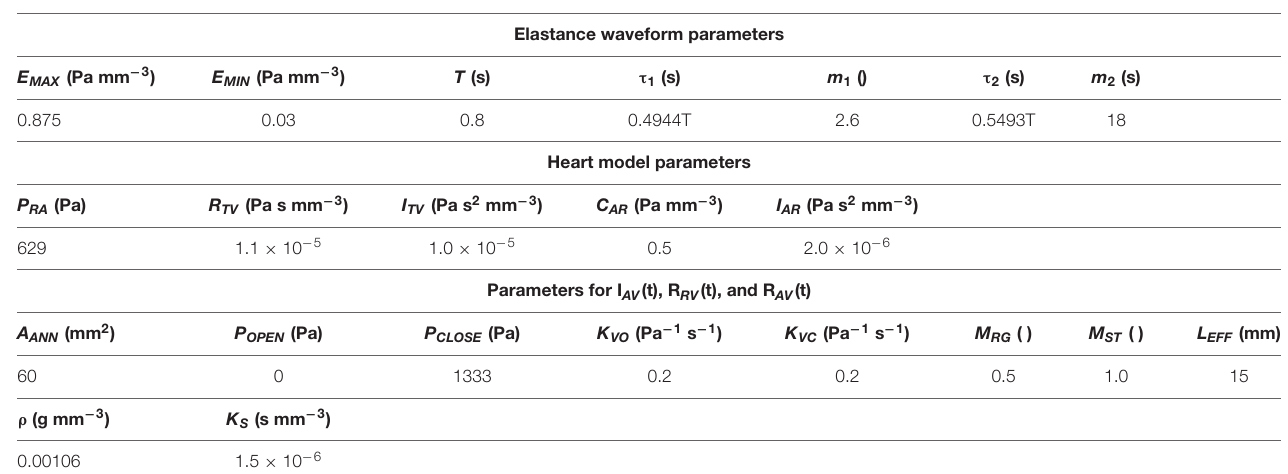
FIGURE 4 | 3D-0D open loop model of the HLHS patient includes an FSI model of the Fontan circulation containing venae cavae, pulmonary arteries and fenestration, and lumped-parameter network of models representing the single ventricle heart and vasculature proximal and distal to the FSI model. A single ventricle heart model was placed in series with 3-element Windkessel models representing the upper and lower body vasculature, respectively. Flow is directed into the SVC and IVC and leaves the 3D domain through the LPA, RPA, and fenestration. The parameters of the single ventricle heart model, Windkessel, and wall properties of the FSI model were simultaneously tuned to match patient-specific mean flow, backflow, and pressure data. The patient-specific RV elastance function described the active contraction of the single ventricle heart model. TABLE 1 | Parameter values and units for components of the single ventricle heart